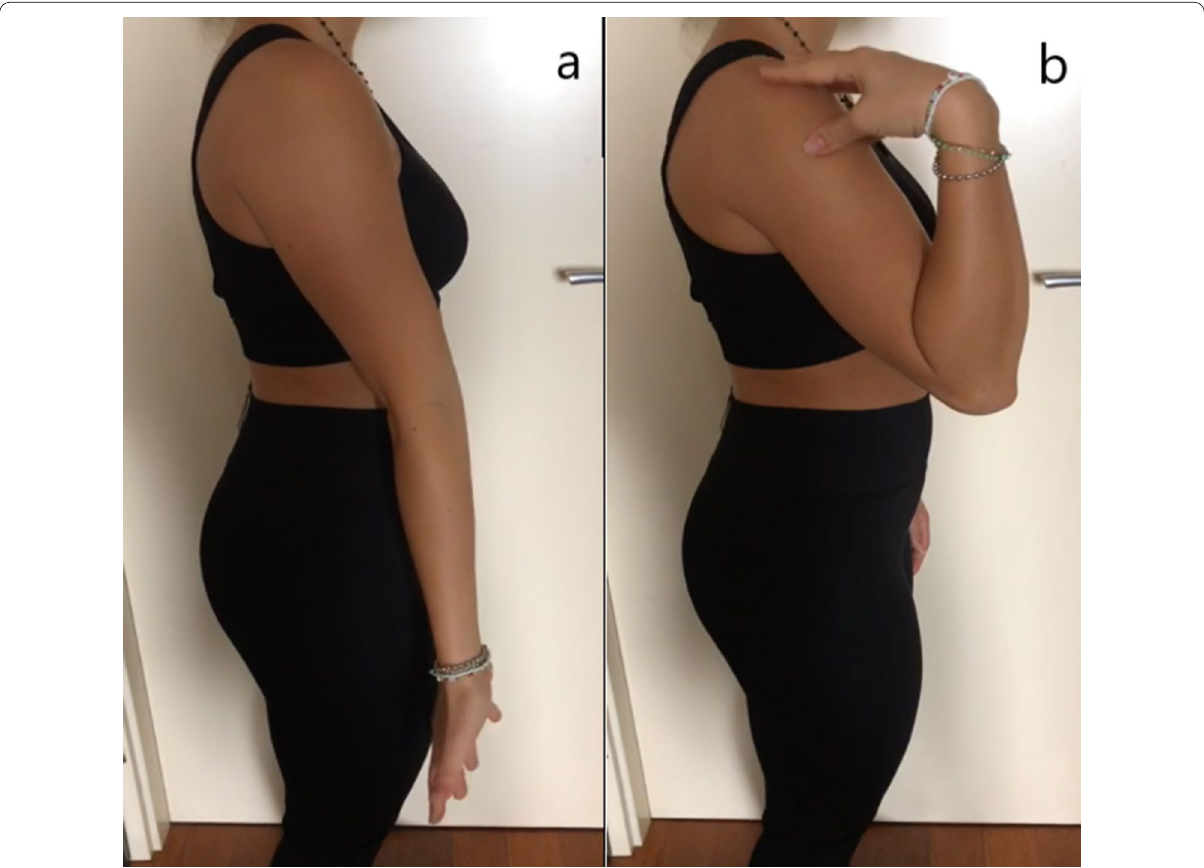
Fig. 4 Full elbow range of motion after arthroscopy. Postoperative ROM improvement achieved after arthroscopy by one of our young athletes, with complete arc of flexion ( b ) and extension ( a